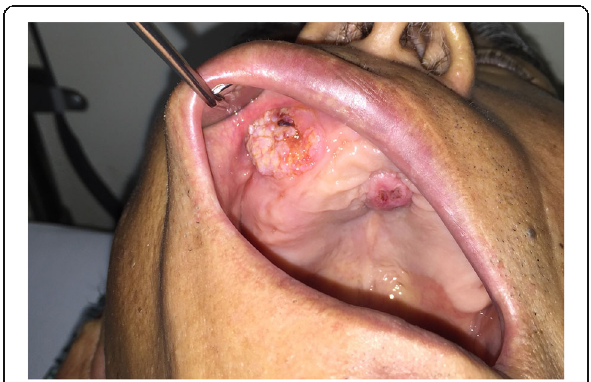
Fig. 1 Clinical photograph showing papillary exophytic growths of the labial parts of the maxillary right anterior edentulous ridge and middle of the